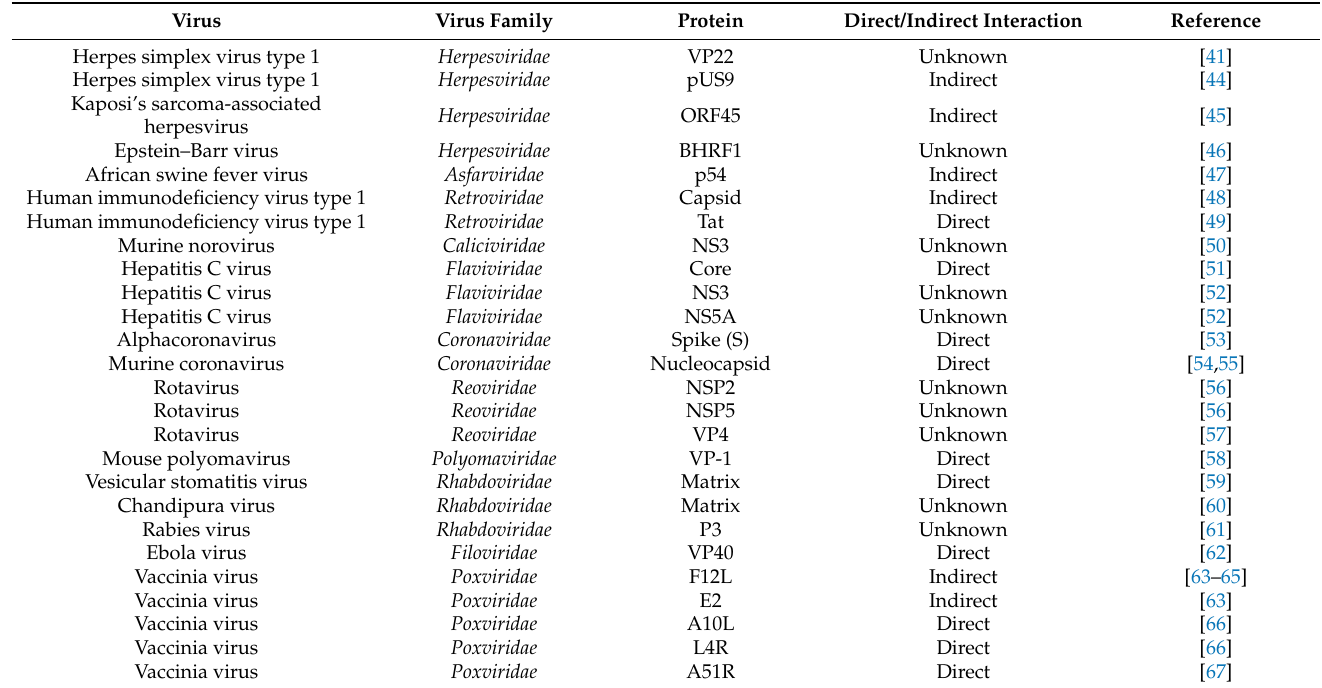
Table 1. List of reported viral